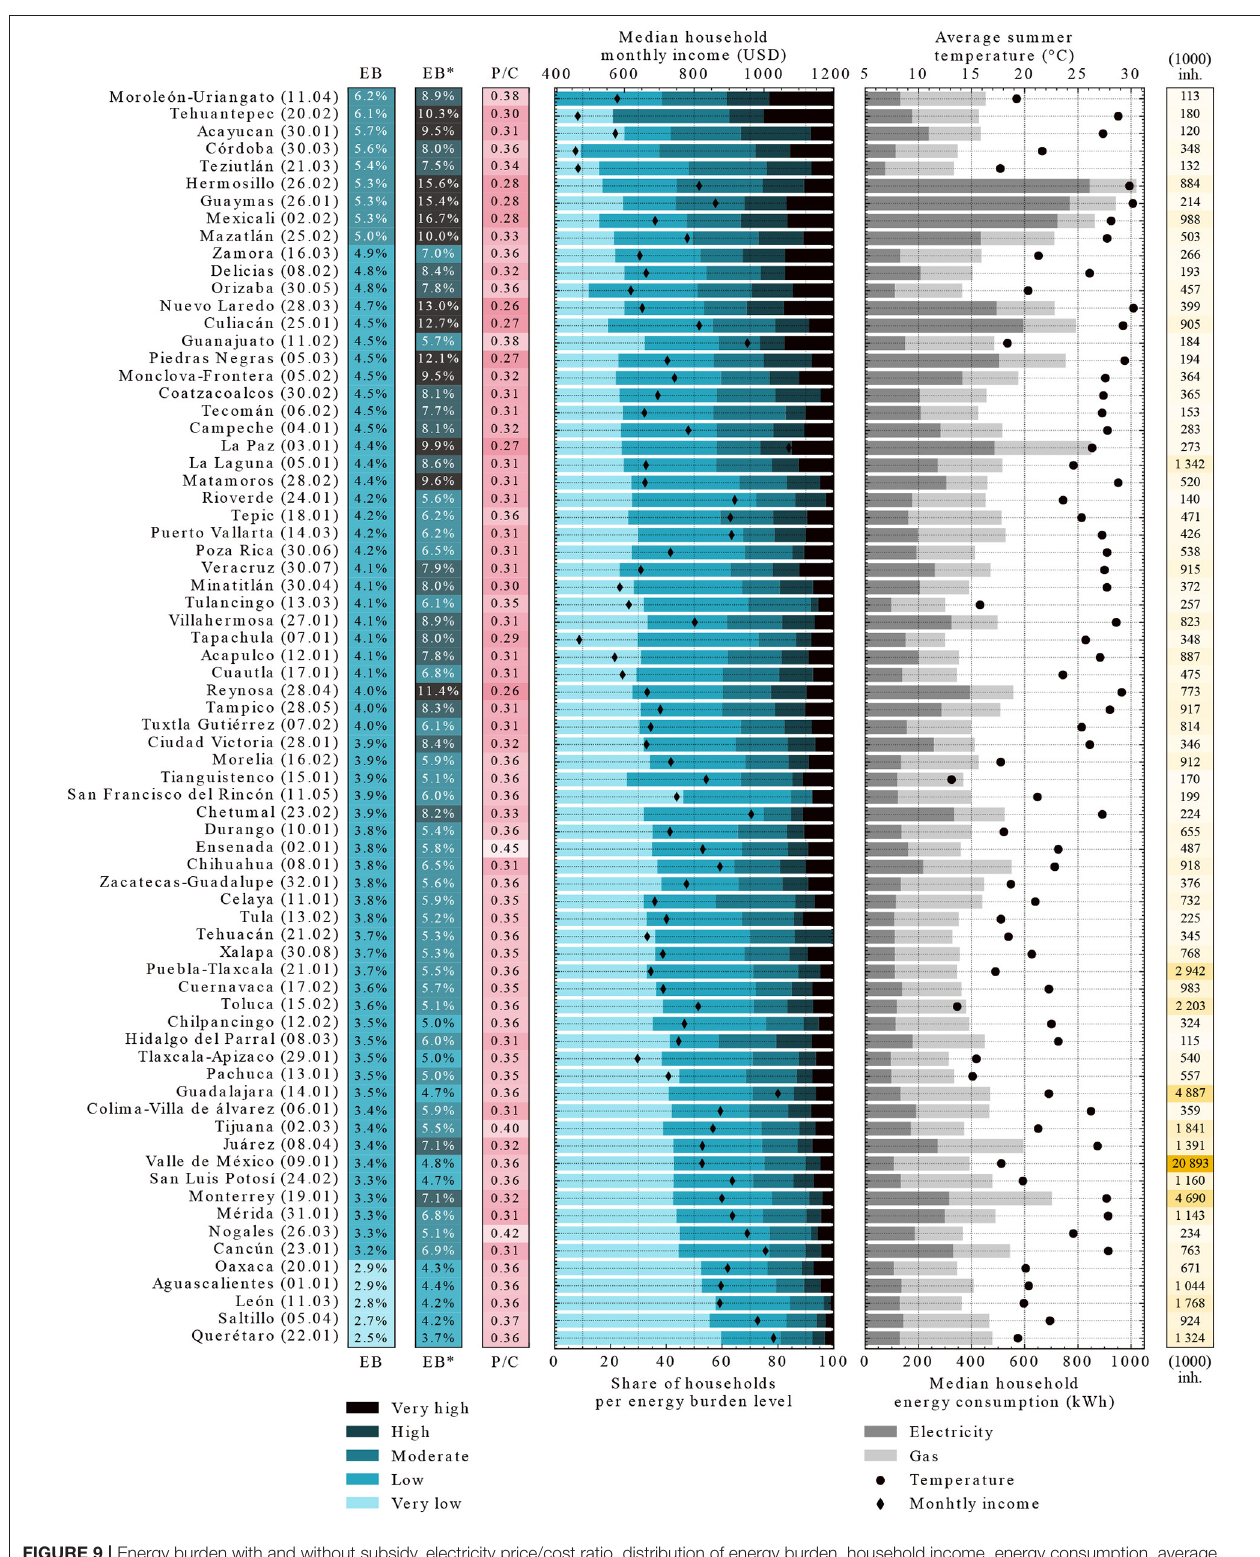
FIGURE 9 | Energy burden with and without subsidy, electricity price/cost ratio, distribution of energy burden, household income, energy consumption, average minimum summer temperature, and population of 72 metropolitan areas in Mexico.